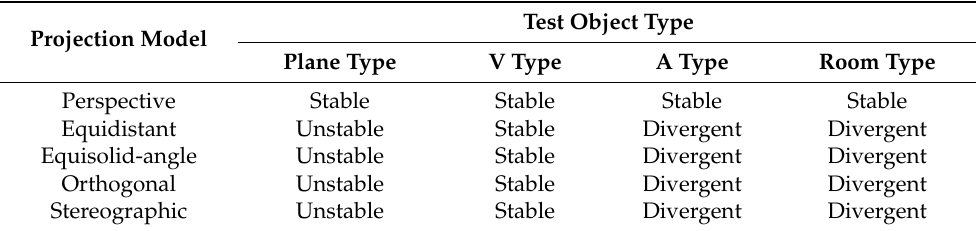
Table 5. Self-calibration stability.